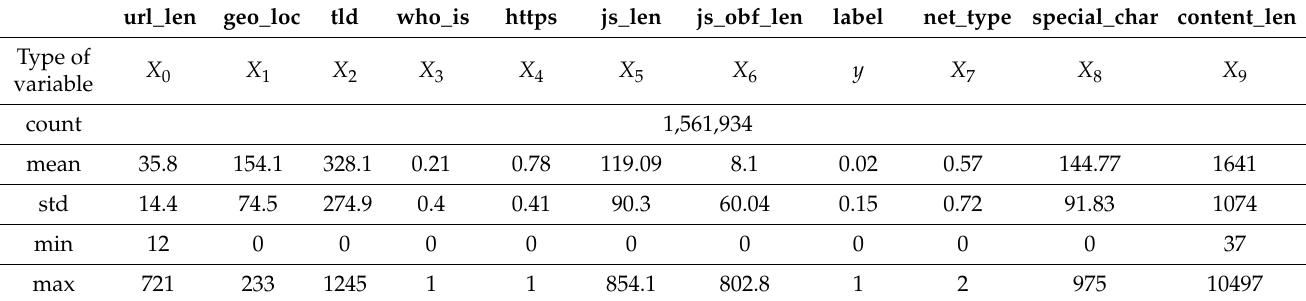
Table 4. The statistical analysis of the original dataset, after all, columns transformed into